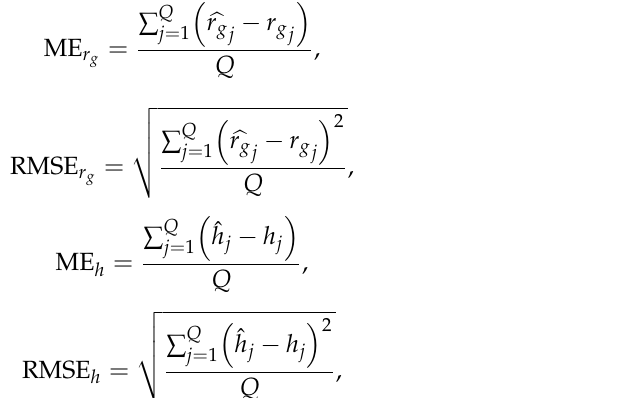
Figure 9. The simulated scenario in experiment 2: ( a ) the amplitude of simulated scatterers, ( b ) the phase of simulated scatterers, ( c ) the 2-D SAR image from master antenna.